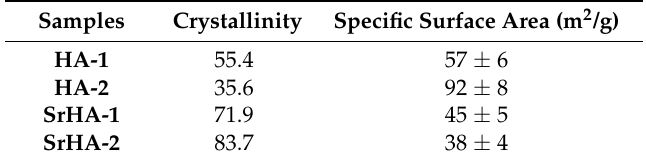
Figure 1. X-ray diffraction (XRD) patterns of the prepared samples. SrHAs exhibited sharper diffraction peaks than those of HAs, those indicating a higher crystallinity. Table 1. Crystallinity and specific surface area of the synthesized samples.